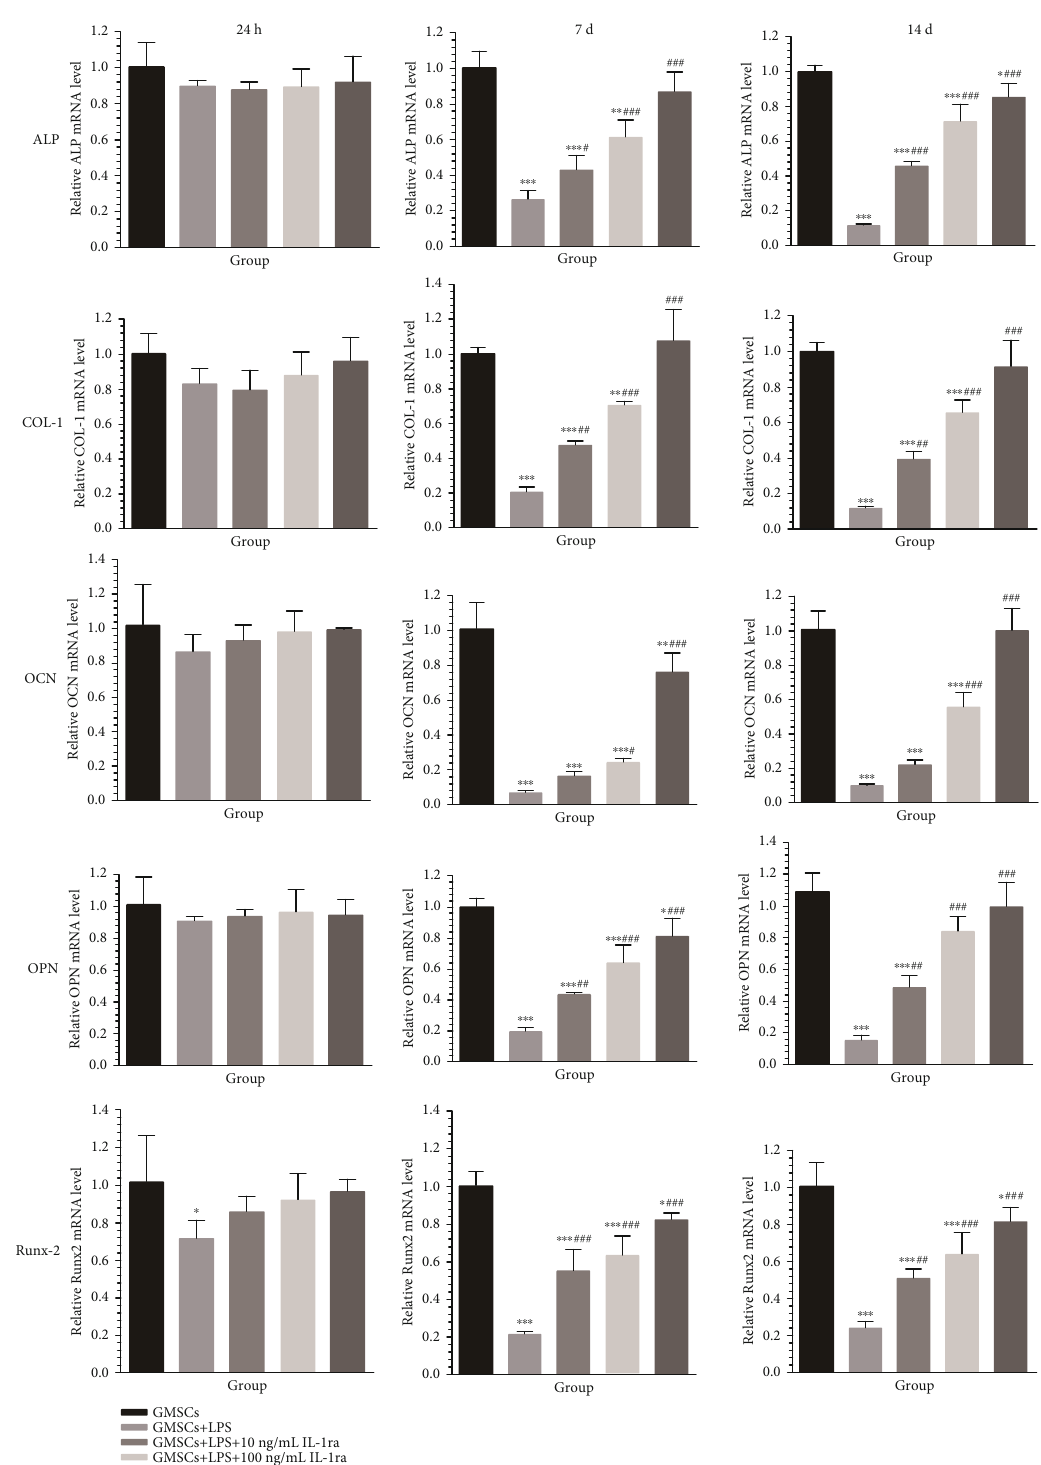
Figure 7: mRNA expression of osteogenic genes including ALP, COL-I, OPN, OCN, and RNX2 in di ff erent groups after 24 hours, 7 days, and 14 days of osteogenic induction, detected by RT-PCR. ∗ P < 0 : 05 , ∗∗ P < 0 : 01 , and ∗∗∗ P < 0 : 001 vs. GMSCs; # P < 0 : 05 , ## P < 0 : 01 , and ### P < 0 : 001 vs.